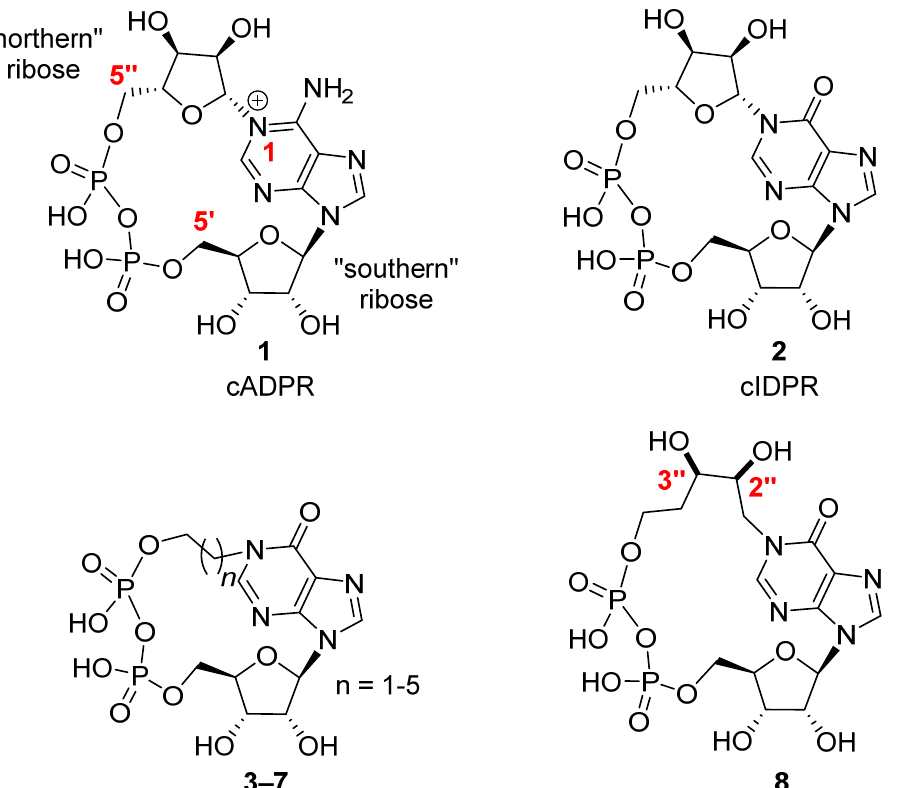
Figure 1. The structures of cADPR ( 1 ), cIDPR ( 2 ) and their analogues ( 3 – 8 ). As the last mimic possesses the two OH groups in a ribose-like fashion, it may be considered the closest cIDPR flexible analogue. Interestingly, the cyclic compound 8 induced a concentration-dependent increase in [Ca 2+ ] i when perfused to primary cortical neurons as efficiently as